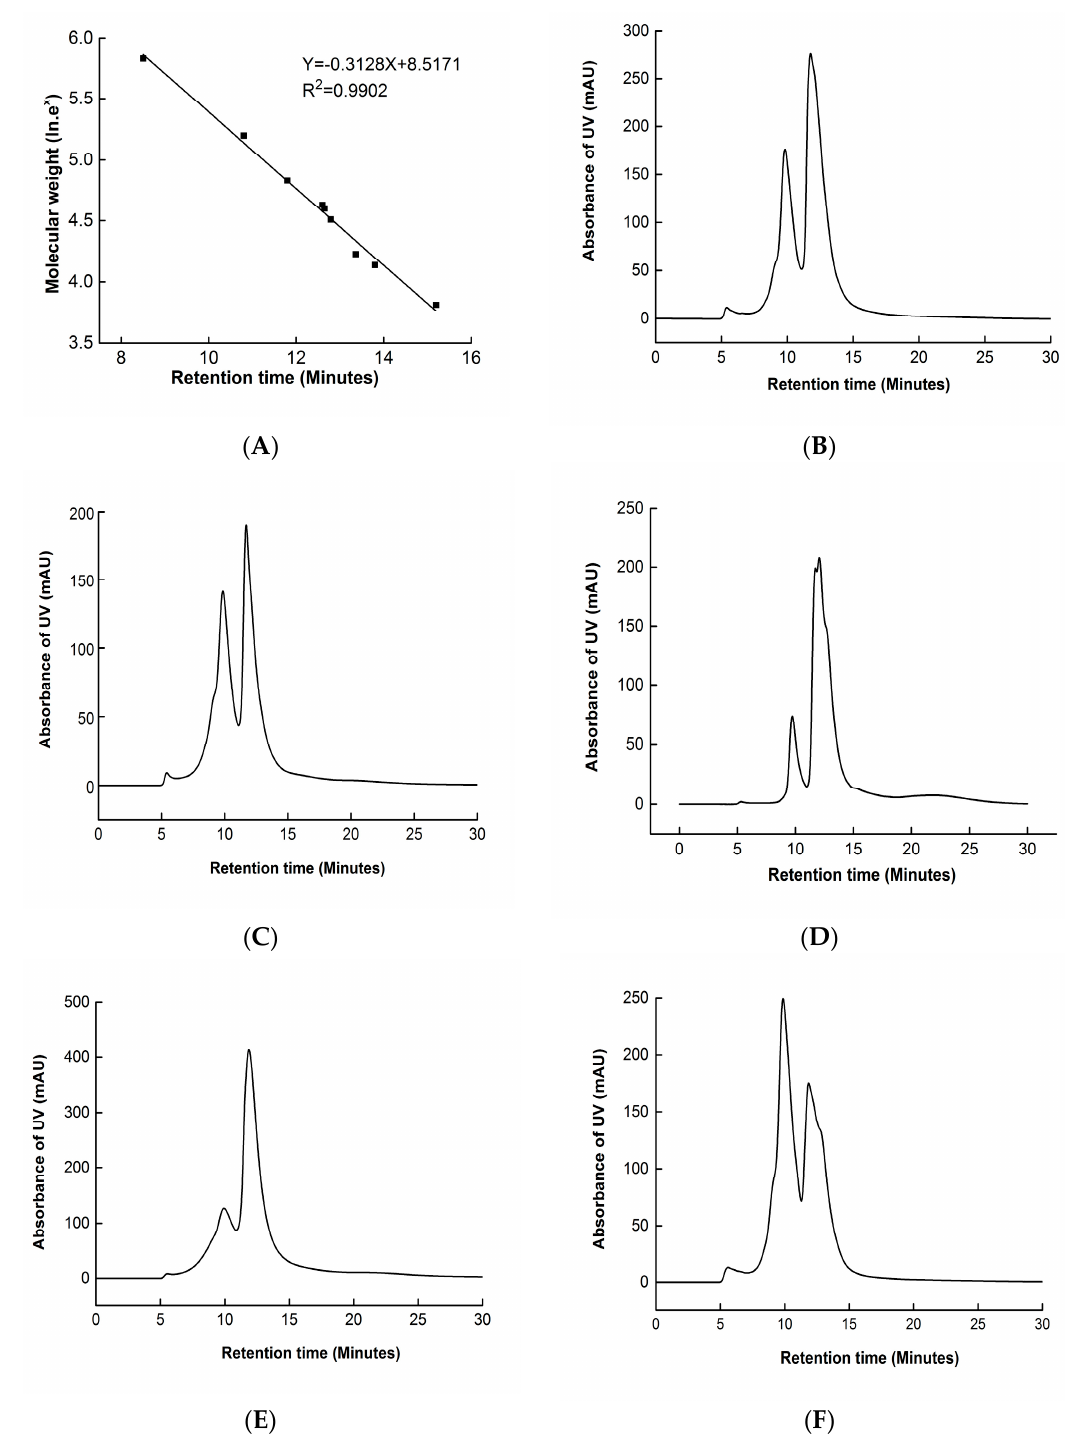
Figure 3. HPSEC of walnut protein incubated with different concentrations of MDA. Calibration curve of nine standard proteins used for interpreting the results: thyroglobulin (MW: 669,000); aldolase (MW: 158,000); BSA (MW: 67,000); ovalbumin (MW: 43,000); peroxidase (MW: 40,200); adenylate kinase (MW: 32,000); myoglobin (MW: 17,000); and ribonuclease. ( A ) (MW: 13,700), and aprotinin (MW: 6500); ( B ) 0 mM; ( C ) 0.01 mM; ( D ) 0.1 mM; ( E ) 1 mM; and ( F ) 10 mM.